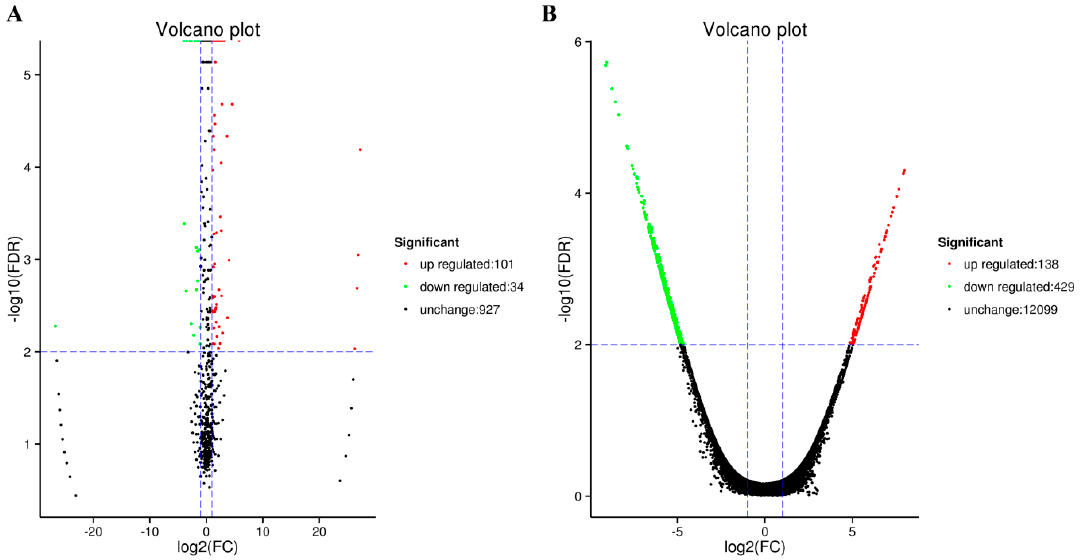
Figure 1. The volcano plots of differentially expressed miRNAs and mRNAs in fresh and frozen ‐ thawed boar sperm. ( A ) miRNAs; ( B ) mRNAs. Each point in the Volcano plot represents a miRNA or an mRNA. Black dots represent miRNA or mRNA with no difference in expression, red dots represent the up ‐ regulated miRNA or mRNA, and green dots represent the down ‐ regulated miRNA or mRNA.